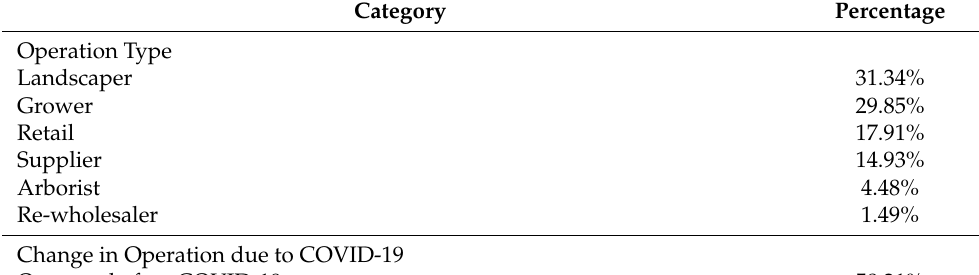
Table 1. Characteristics of survey respondents.